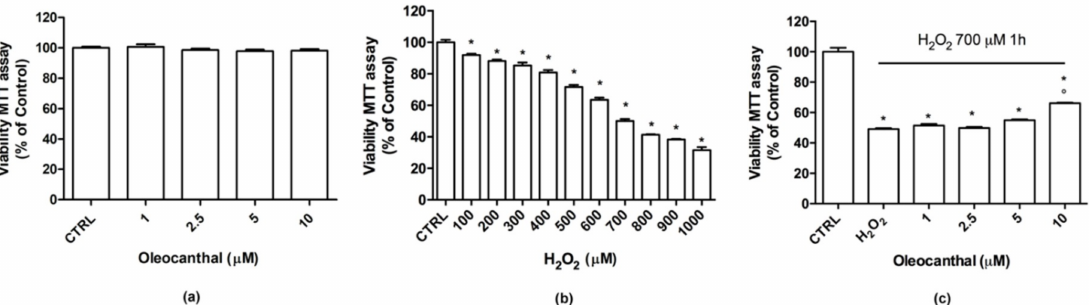
Figure 1. Viability of differentiated SH-SY5Y treated with oleocanthal in the absence/presence of H 2 O 2 . ( a ) Cells were treated with oleocanthal (1–10 µ M) for 24 h, ( b ) cells were treated with peroxide (0.1–1 mM), or ( c ) cells were treated with oleocanthal (1–10 µ M) and after 24 h exposed to 700 µ M H 2 O 2 for 1 h; cell viability was measured by MTT assay. Each bar represents means ± SEM of at least